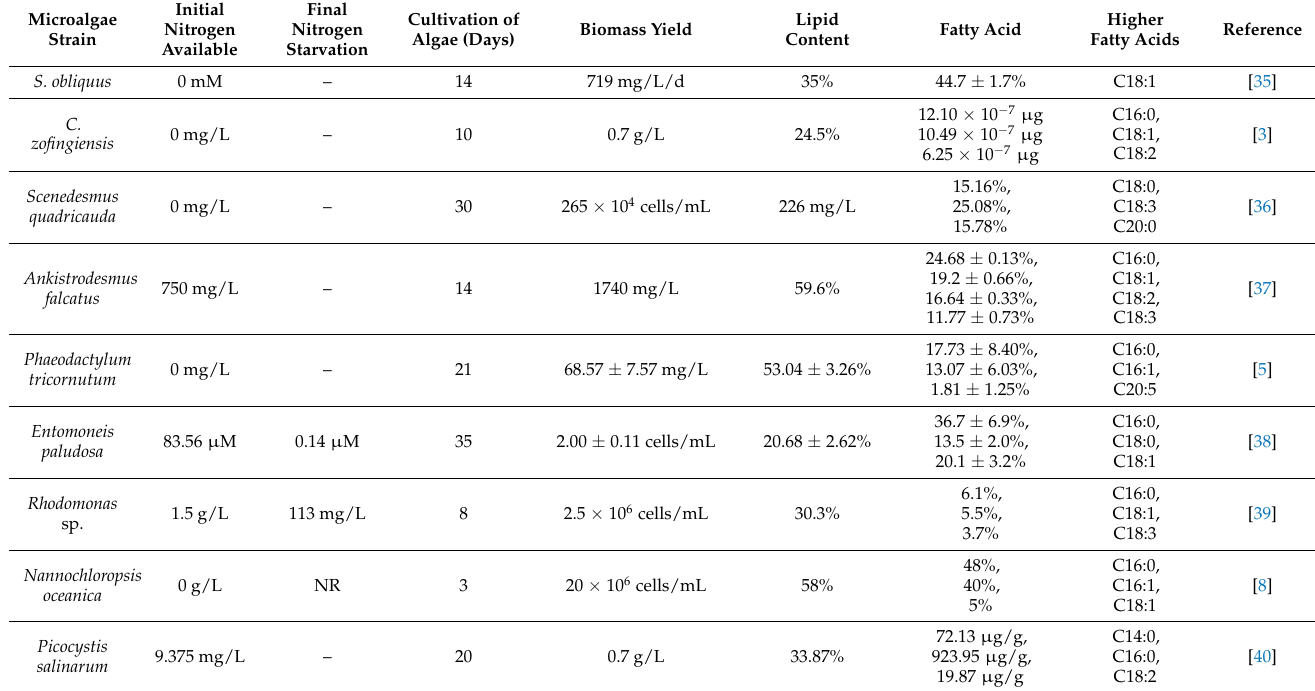
Table 2. Effect of nitrogen availability and starvation conditions on biomass yield, lipid content and fatty acids in algae. Microalgae